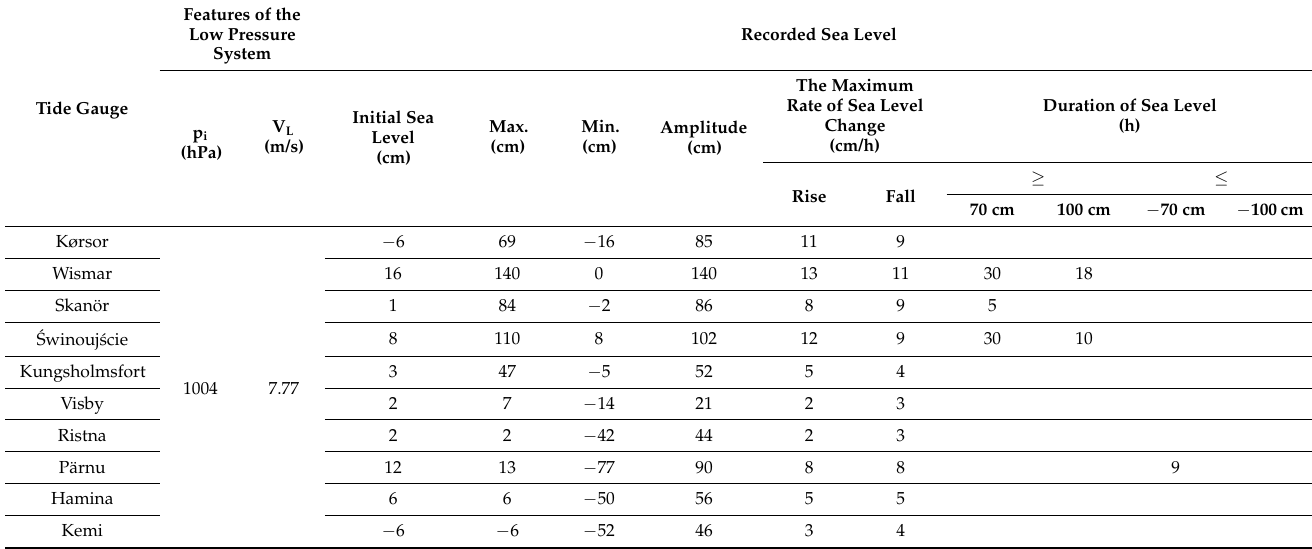
Figure 4. Distribution of wind direction and velocity together with sea level changes in individual Baltic Sea sub-basins from 13 to 16 October 2020. A stable increase followed by slow decrease in sea level in the Western Baltic (the stations at Skanör, Wismar, and ´Swinouj´scie) driven by changes in velocity of the northeastern onshore wind. (Legends: blue line—sea level; black arrow—wind direction; columns—wind velocity). Table 1. Features of the low pressure system and parameters of the storm surge analyzed in the period of 13–16 October